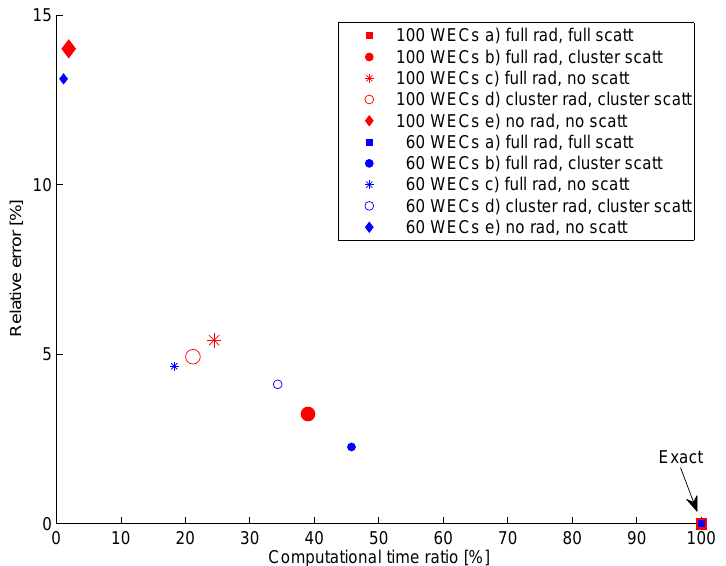
Figure 5. Computational time ratio vs . relative error of farm simulations with the different interaction distance cut-off shown in Figure 3. The exact values (highlighted in the figure) are for farms with full diffraction and radiation interaction. The farms with 100 WECs are plotted in red, larger markers; the farms with 60 WECs in blue, smaller